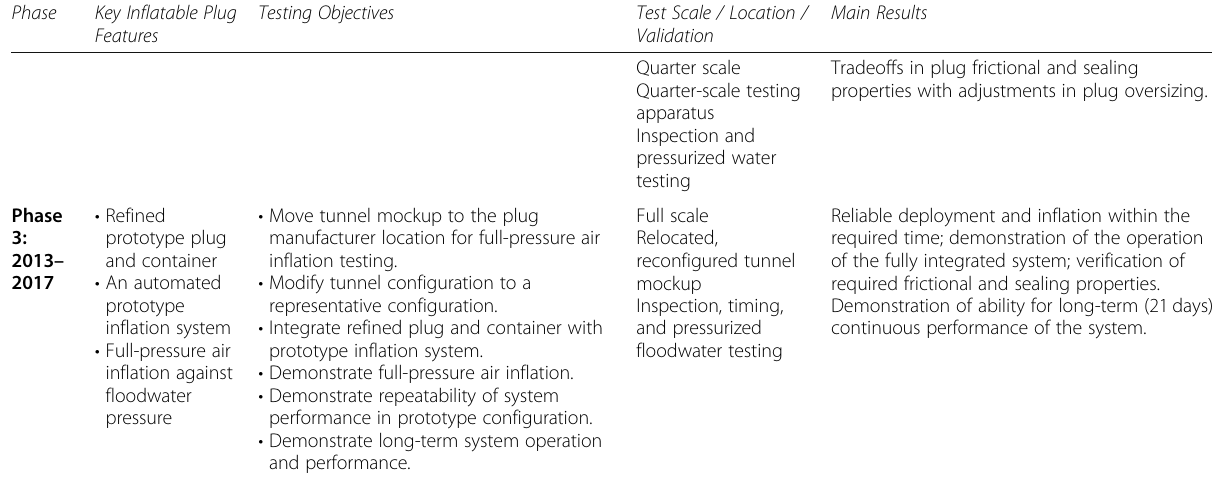
Table 2 Summary of key parameters, objectives, and main results obtained from each phase (Continued) Phase Key Inflatable Plug